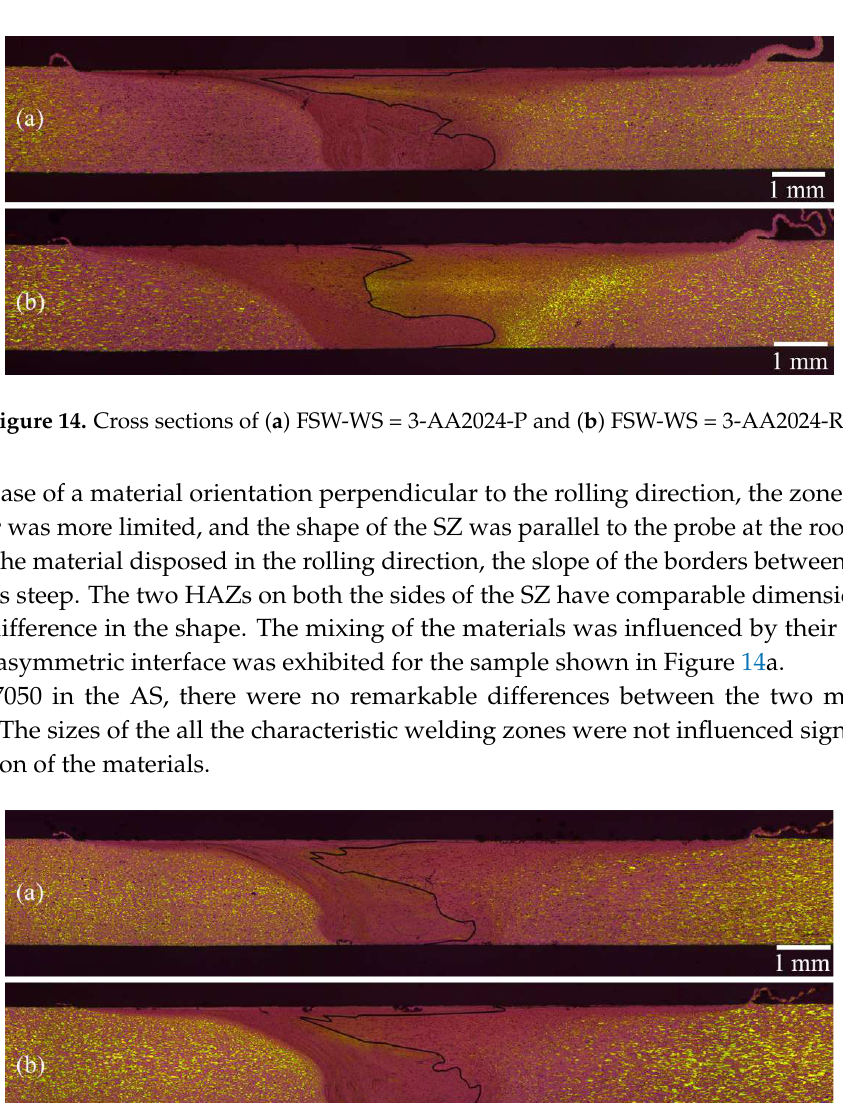
Figure 15. Cross section of ( a ) FSW-WS = 5-AA7050-P and ( b ) FSW-WS = 5-AA7050-R. The “onion rings” did not change shape or orientation, indicating that the rolling or